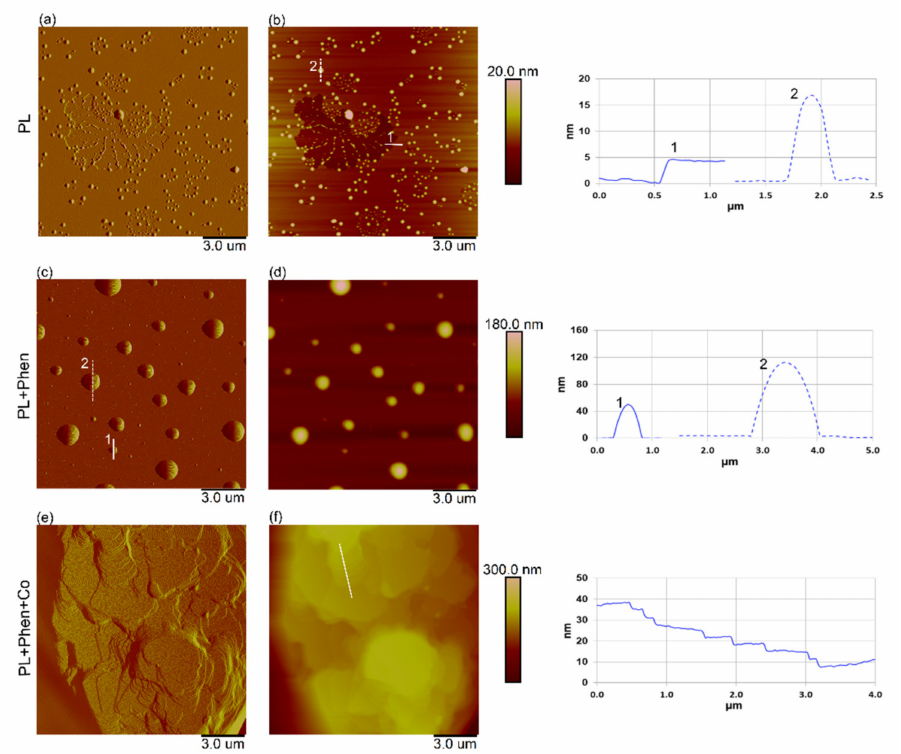
Figure 6. AFM images of natural phospholipid (PL) on the mica surface: amplitude data ( a ) and height ( b ) of PC alone; amplitude data ( c ) and height ( d ) of PC with Phen (1:1) and amplitude data ( e ) and height ( f ) of PC, Phen and Co(II) (1:1:1). Heights of cross-sections marked on height images are presented